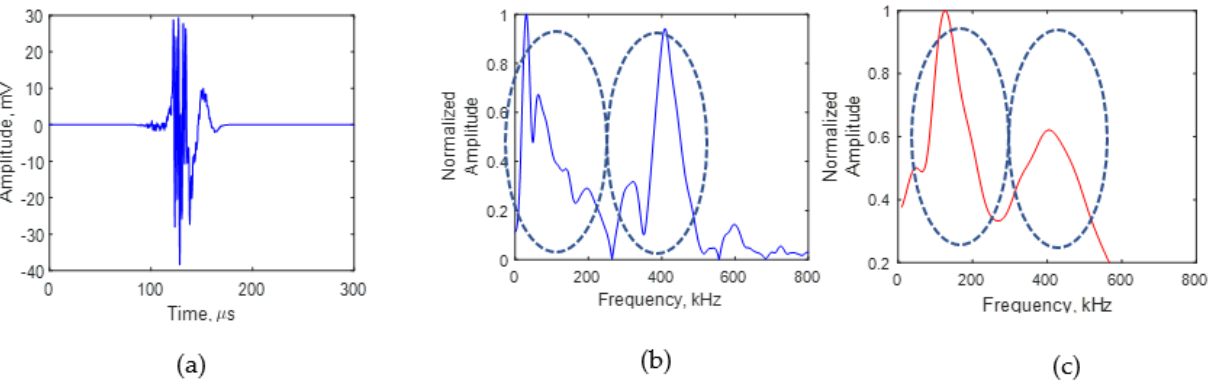
Figure 11. AE signal for a crack length of 8 mm: ( a ) experimental signal recorded using PWAS sensor; ( b ) experimental frequency spectrum; ( c ) simulation frequency spectrum.